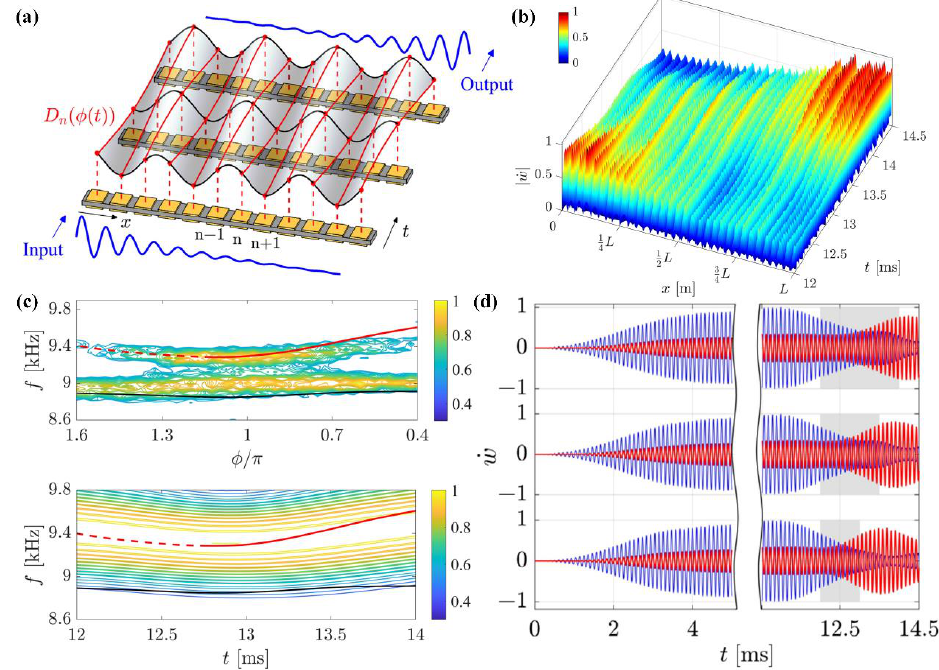
Figure 8. Temporal pump in electromechanical waveguides [135]. ( a ) The electromechanical elastic beam with modulated bending stiffness ( ( )) n D t . ( b ) The schematic of the transient pump. ( c ) The dispersion diagram in quasistatic conditions (top) or in the time domain (bottom). ( d ) The influence of different phase modulation durations (top, 2 ms; middle, 1.5 ms; bottom, 1 ms) on edge-to-edge transitions.